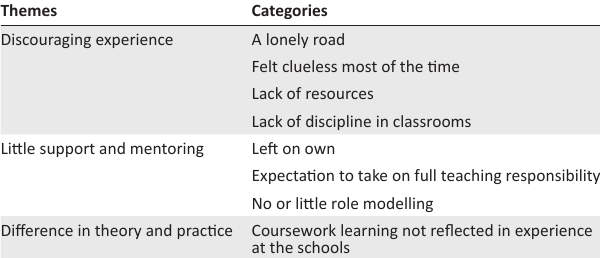
TABLE 2: Student teachers’ views on their practice learning experiences at work integrated learning